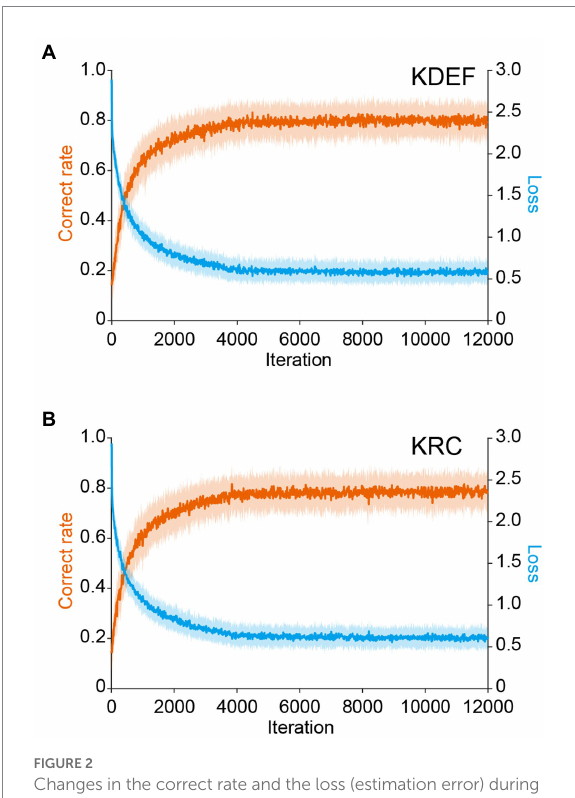
FIGURE 2 Changes in the correct rate and the loss (estimation error) during training. The correct rates (orange lines) and loss values (cyan lines) are plotted as a function of the iteration number for the KDEF-trained CNNs (A) and the KRC-trained CNNs (B) . They were computed with the training dataset. The solid lines and shaded areas represent the means and standard deviations across 40 runs, respectively. Every 10th value is plotted along the horizontal